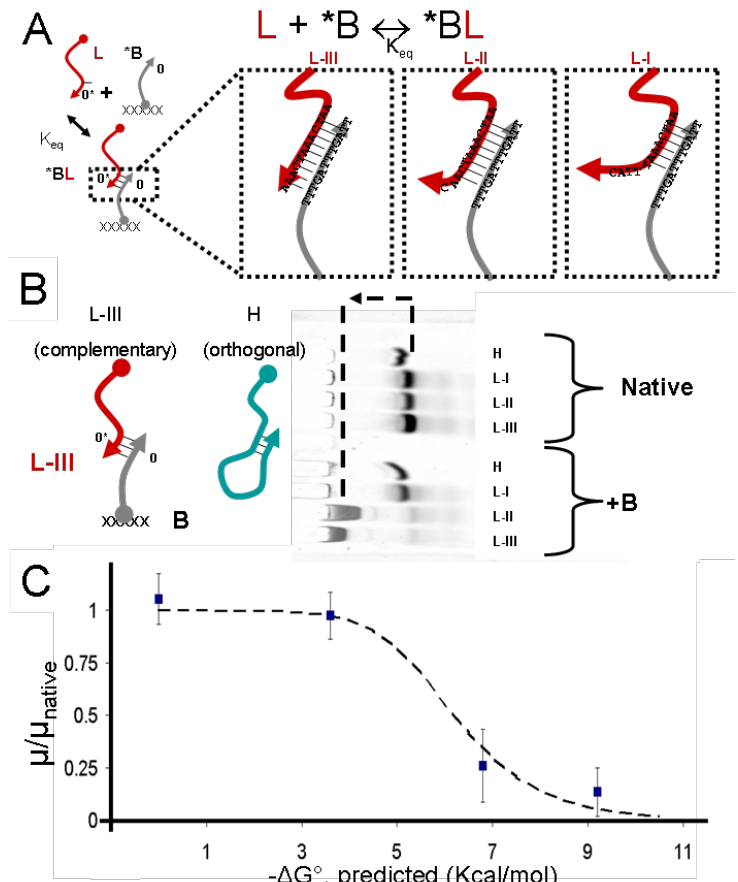
Figure 1. Mobility is controlled by complementarity to an immobile